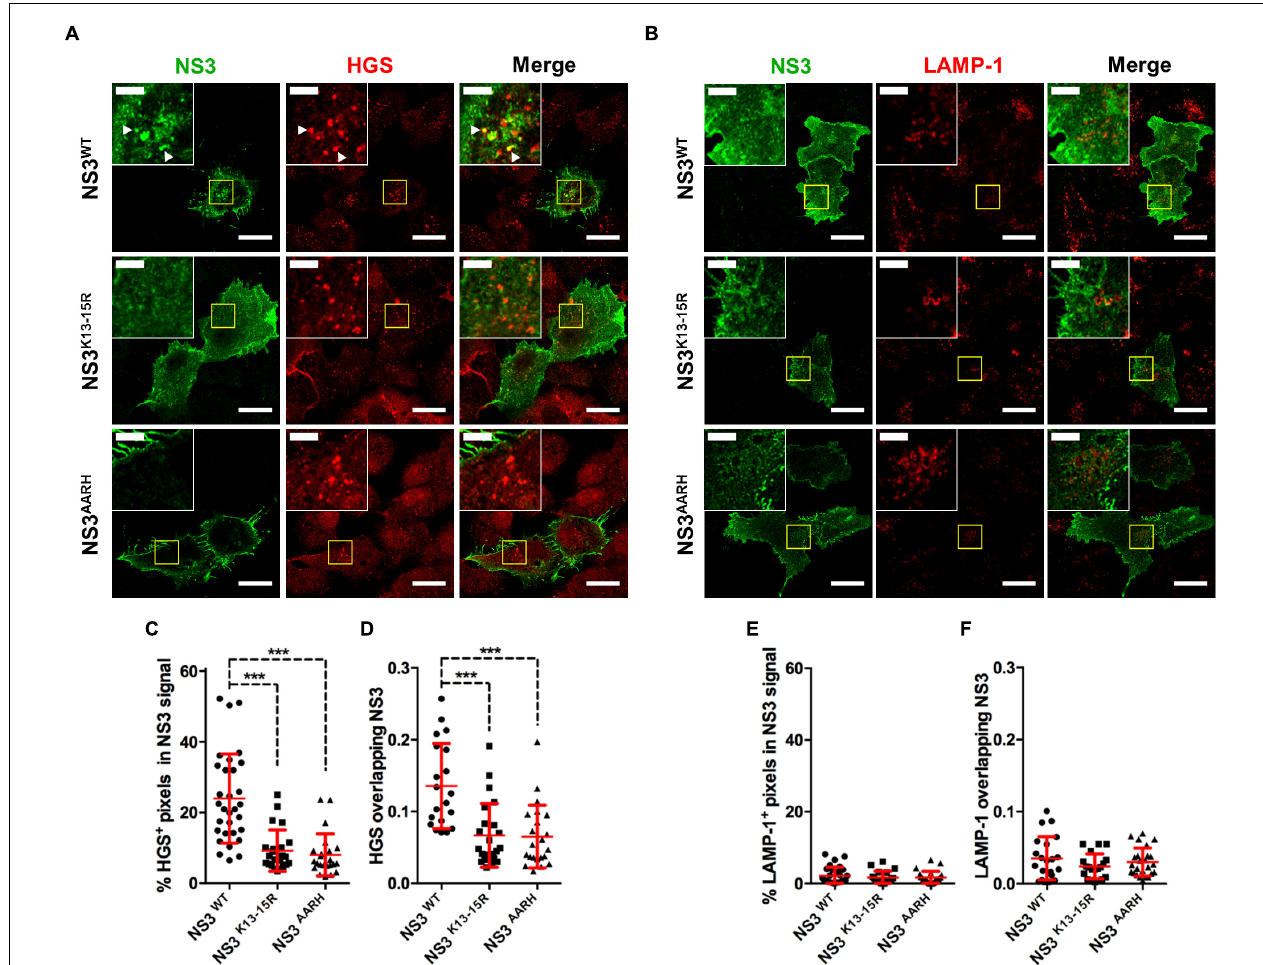
FIGURE 5 | NS3 traffics through the MVB. (A,B) Representative immunofluorescence staining of Vero cells transfected with plasmids expressing Flag-tagged NS3 WT , NS3 K 13 − 15 R (ubiquitination site mutation), or NS3 AARH (E3 ligase binding domain mutation) and stained for NS3 with anti-FLAG tag antibodies [Cell Signaling, #14793 (D6W5B)], and for (A) the MVB marker HGS (Abcam, ab72053) or (B) the lysosome marker LAMP-1 (BioLegend, 328612). Scale bar = 20 µ m. Inset shows selected areas and arrowheads indicate pixel colocalization. Inset scale bar = 5 µ m. (C–F) Pixel colocalization assessment using ImageJ software (http://rsbweb.nih.gov/ij/ US National Institutes of Health). Mean ± SD percentage area per cell of (C) HGS + or (E) LAMP-1 + pixels in NS3 signal. Manders’ coefficient per cell for (D) HGS or (F) LAMP-1 signal overlapping NS3 determined by the ImageJ JACOP plugin are shown. Cumulative data from 2 to 3 experiments with 10–15 cells analyzed per experiments. *** p < 0.001; One way ANOVA with Bonferroni’s post-test. Method details for these assays (plasmid construction, transfection, and immunofluorescence confocal microscopy) can be found in Avia et al. (2019). For NS3 pixel colocalization analysis with HGS or LAMP-1 signal, z-stack images (step 0.5 µ m) of transfected cells were captured for each channel, cell mask obtained (Mulens-Arias et al., 2015), positive signal for each channel was determined with the ImageJ threshold tool and percentage of overlapping pixels in cell masks for each z-plane determined with the ImageJ image calculator tool (“AND” operation). Manders’ coefficient in cell masks was obtained using the JACOP ImageJ plugin (Bolte and Cordelieres,